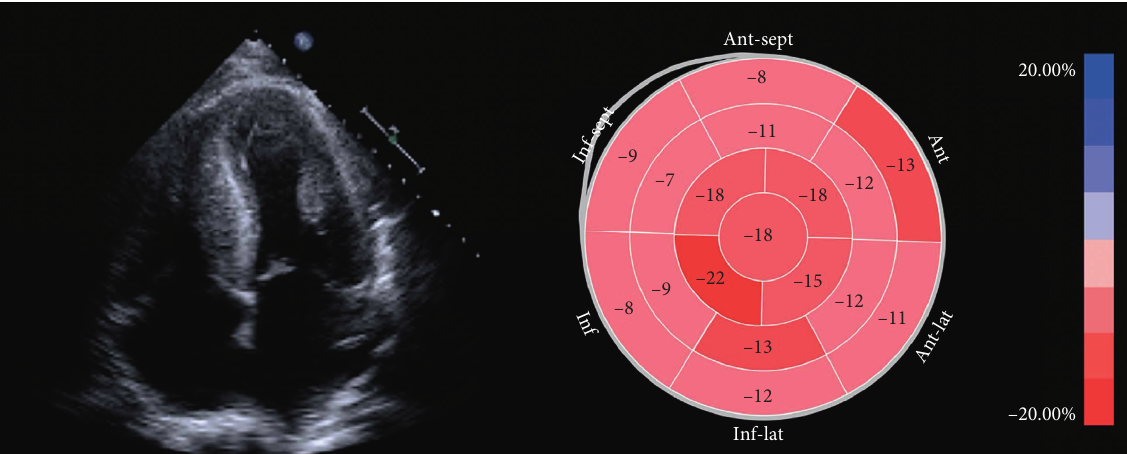
Figure 2: Echocardiography shows low global longitudinal cardiac strain ( − 13.4%) with “cherry on top” pattern (normal value for global longitudinal strain is − 20% and below in healthy individuals). Strain pattern is suggestive of possible cardiac